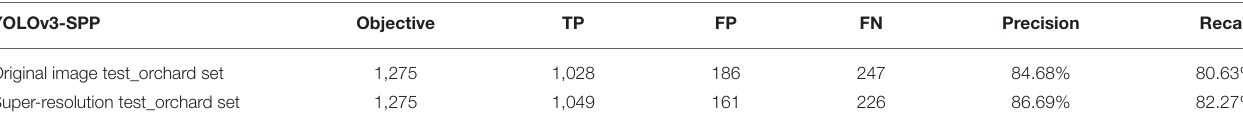
TABLE 4 | The detection results on test_orchard